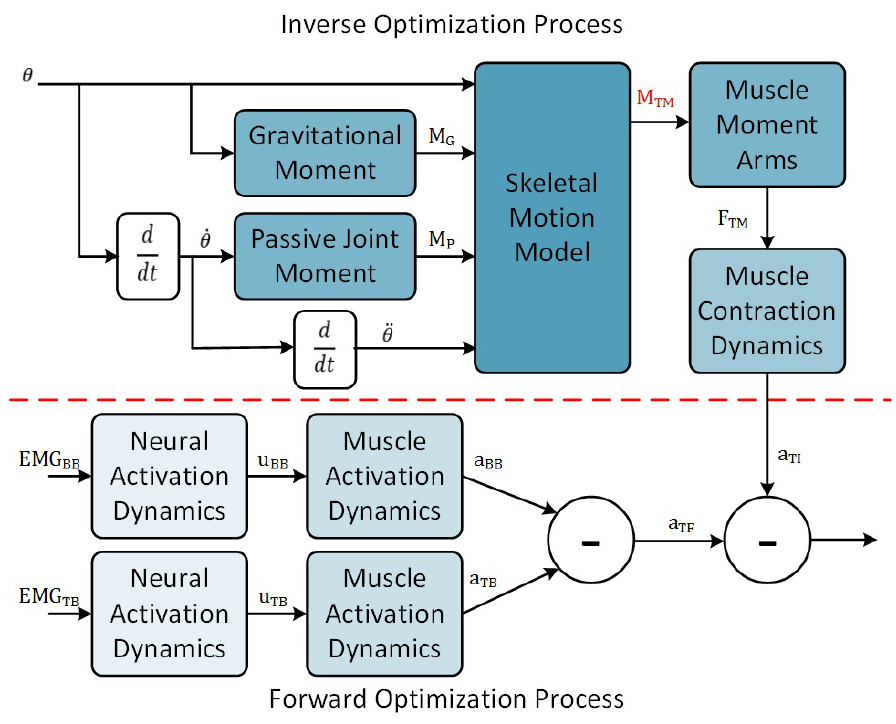
Figure 5. The inverse optimization procedure determines the optimal total muscle torque, M TM , to minimize the elbow joint moment. Then, the total muscle activation, a TI , is derived from the total muscle torque. The forward optimization process minimizes the error in muscle activation signals by determining the optimal parameters values for each muscle activation model. These two processes (separated by the red dotted line) are completed sequentially for each dataset. F TM is the total muscle force; a TI is the inversely-derived total muscle activation; and a TF is the forward-derived total muscle